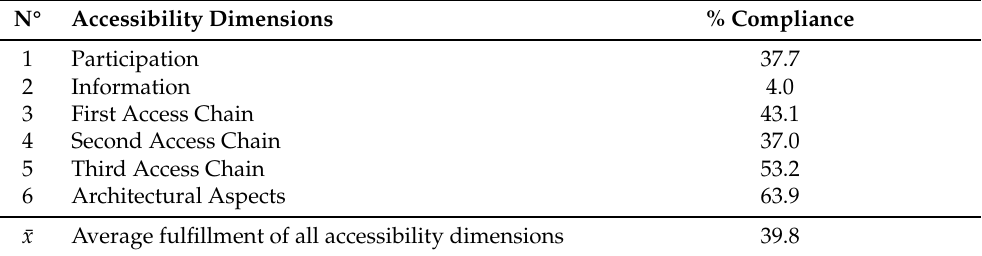
Table 2. Relative frequency of average compliance of PHC centers according to accessibility